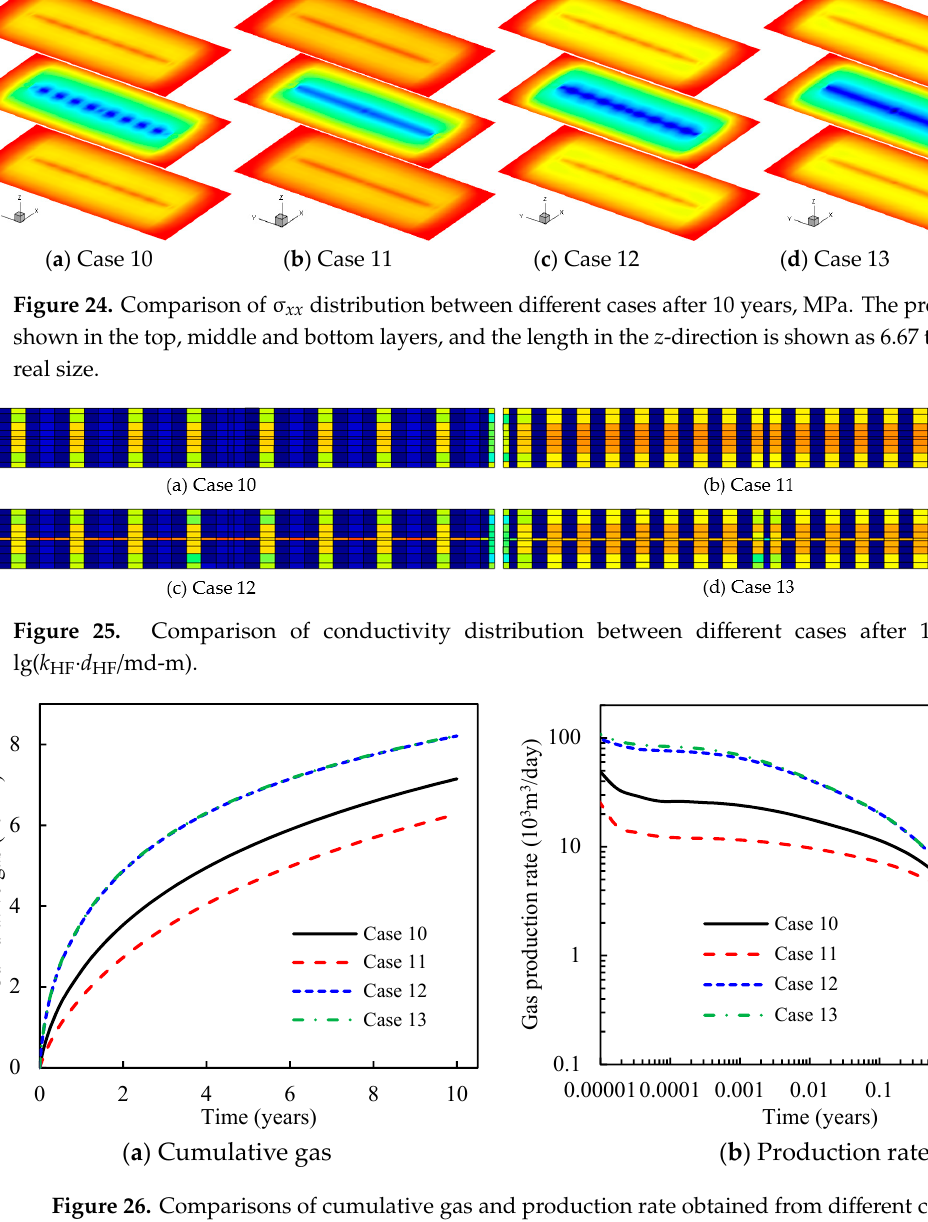
unpropped). unpropped).